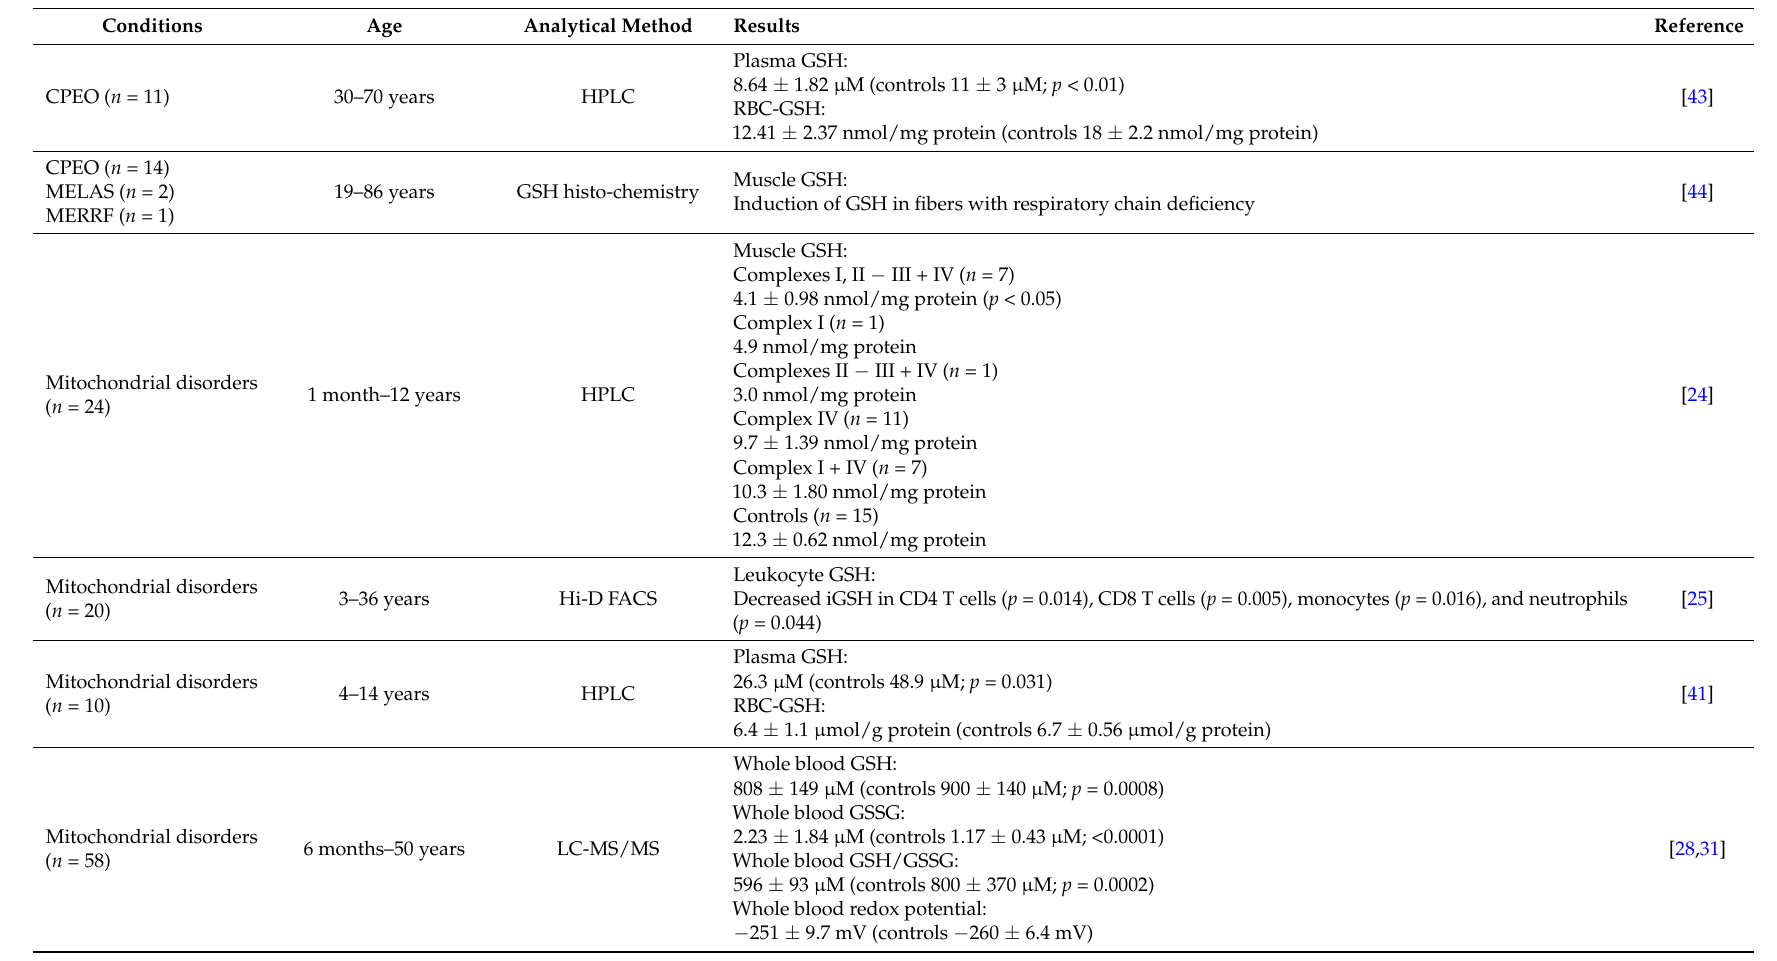
Table 1. Glutathione status in mitochondrial disorders and organic